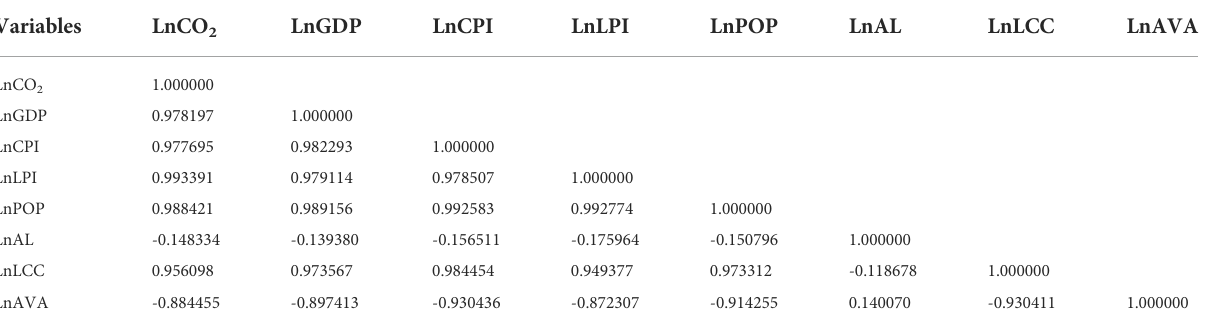
TABLE 3 Correlation